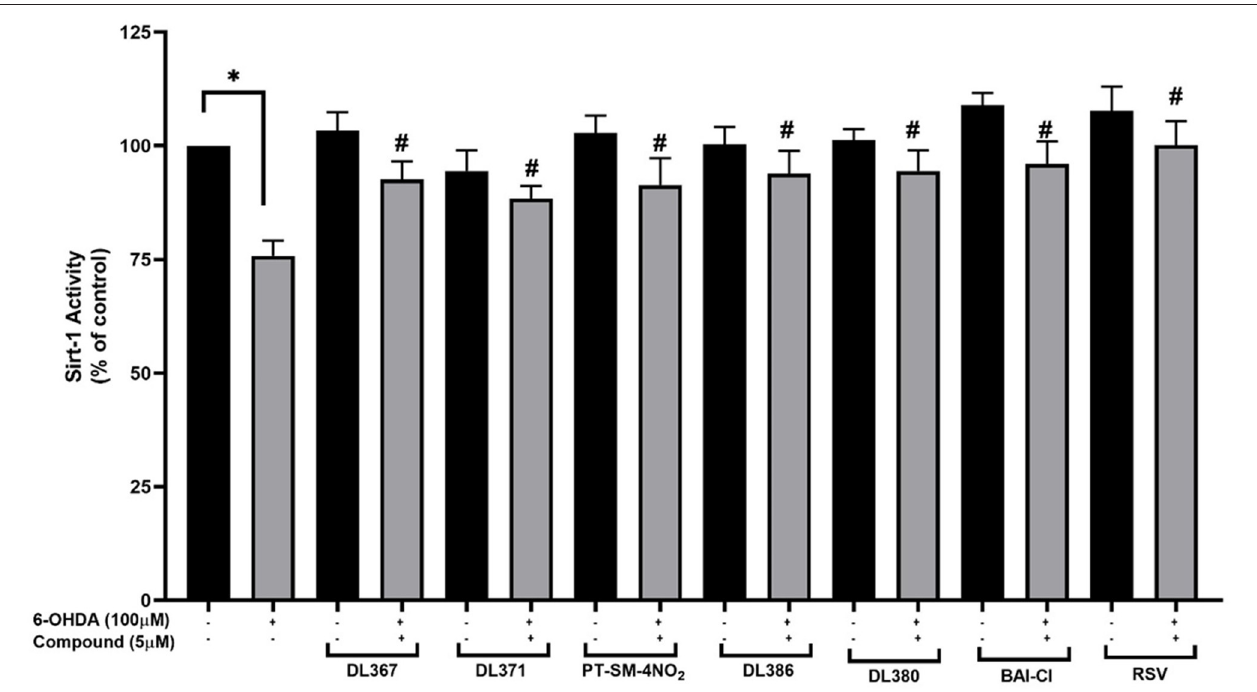
FIGURE 7 | Measurement of SIRT-1 activity. The SH-SY5Y cells were incubated with 5 µ M of bis-sulfonamides or resveratrol for 3h followed by 100 µ M of 6-OHDA for 24h; the cells were extracted in a lysis buffer and scraped from the culture dish followed by centrifugation. The supernatant was collected and determined protein concentration by the Bradford assay and investigated further for SIRT-1 activity. The data are expressed as mean ± SEM, and statistical analysis was performed using one-way ANOVA. * P < 0.05 compared with the control cells; # P < 0.05 compared with the